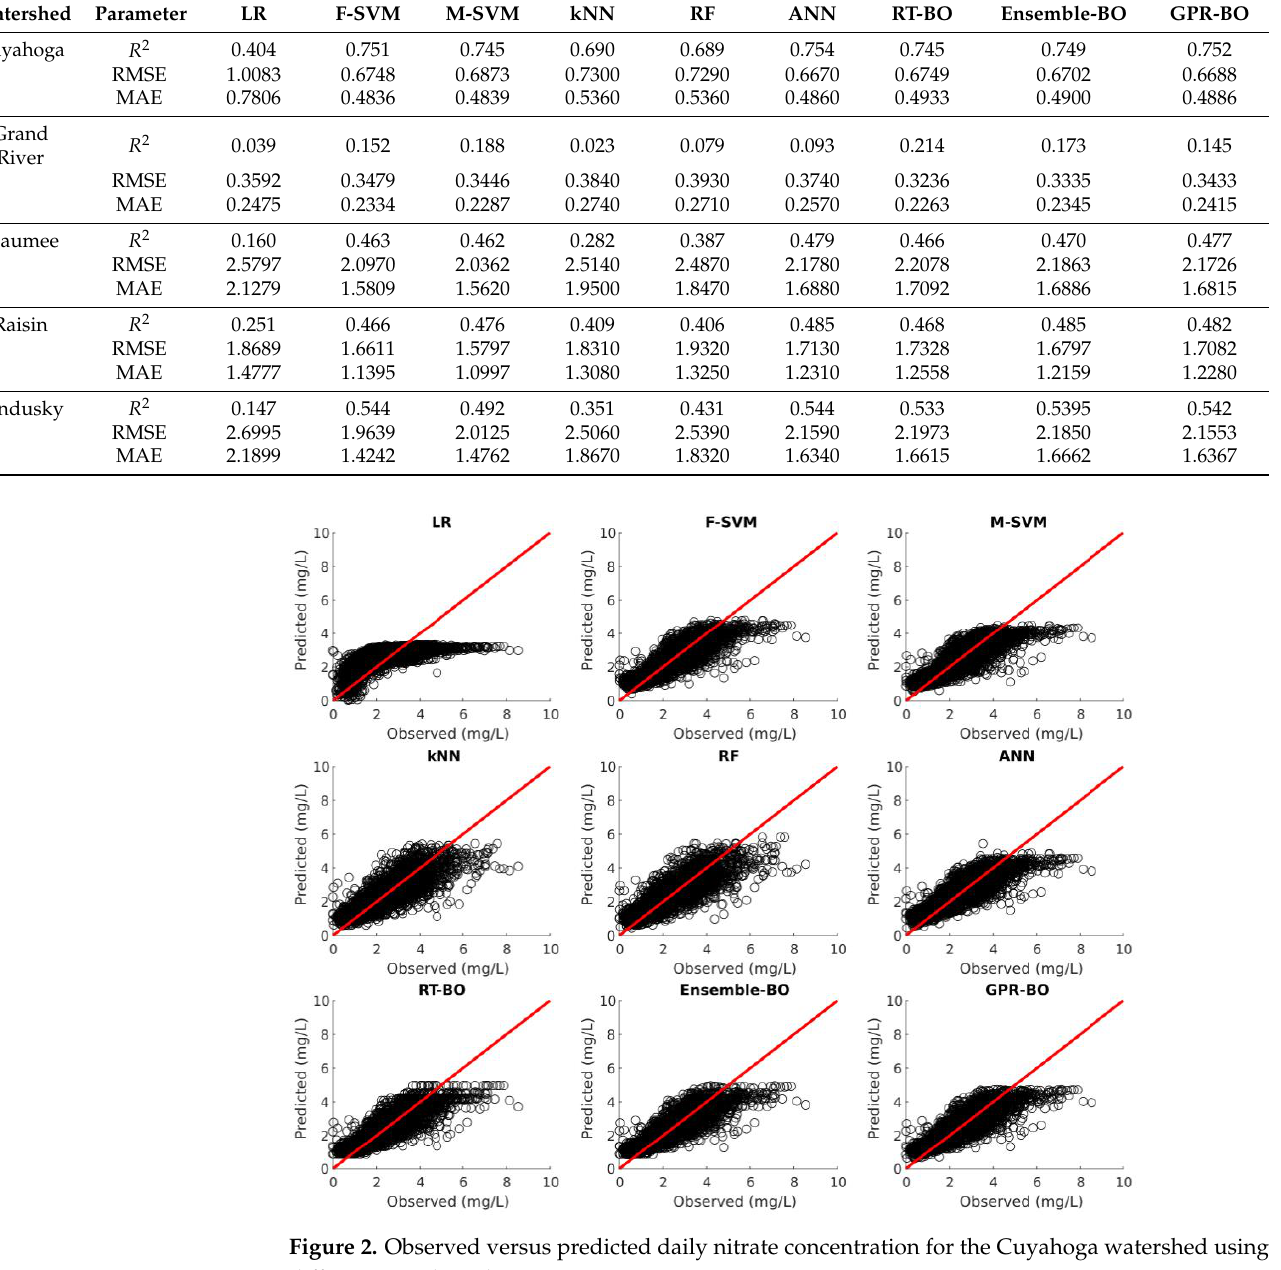
Table 3. Comparison of R 2 , RMSE, and MAE using different ML algorithms for nitrate prediction on test dataset.